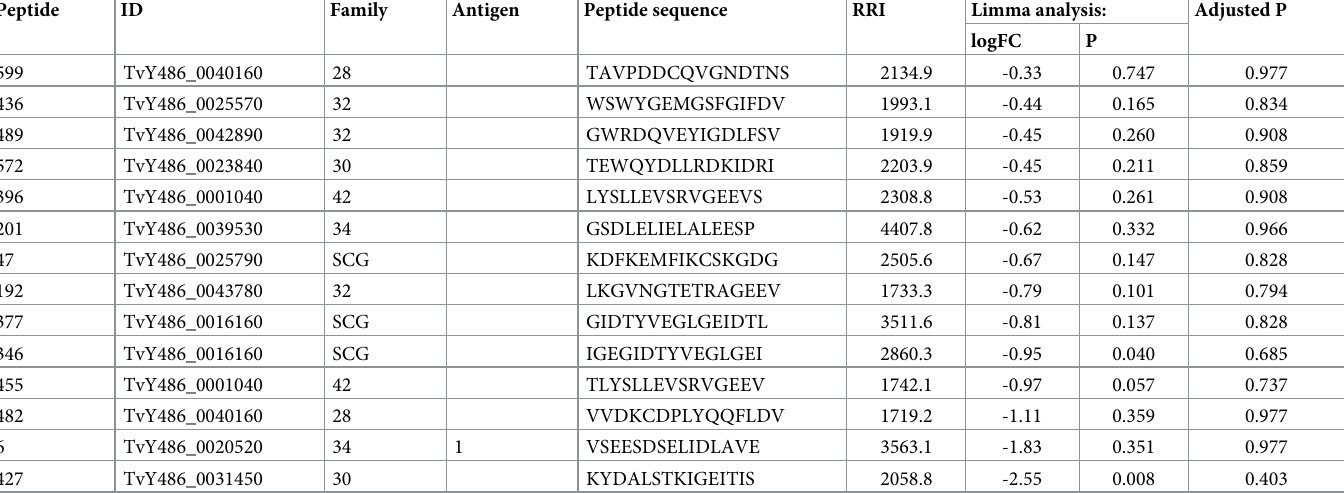
Note: RRI is raw response intensity. Significance of response is expressed as log 2 fold-change relative to fluorescent intensity in uninfected controls. P adj denotes significance after correction for multiple tests (Benjamini). Significant responses shown in bold. SCG: single-copy genes, i.e. T . vivax -specific genes with predicted cell surface expression that are not members of multi-copy gene